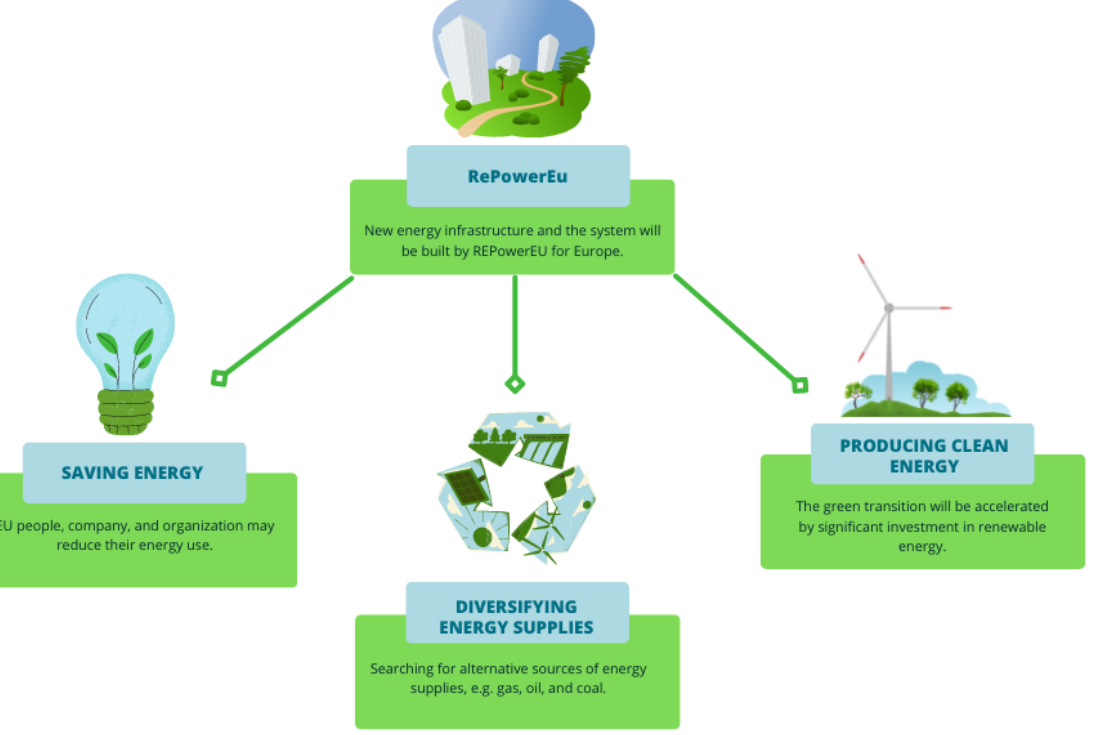
Figure 2. Graphical presentation of REPowerEU plan. Notes: Short-term and medium-term actions are expected to be completed by 2027. Source: Developed by Authors, based on the REPowerEU plan, 2022 [38].